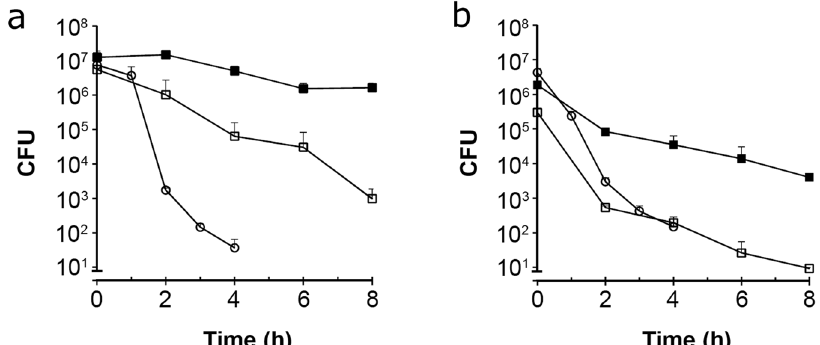
Fig. 6 Antibiotic time-kill assay of P. aeruginosa bio fi lms and dispersed cells. Bio fi lms were grown on pegs for 24 h, and were subsequently treated with 100 μ M H6-335-P1 or DMSO-control for 2 h. Bio fi lms treated with H6-335-P1 ( □ ) and DMSO-control ( ■ ), as well as dispersed cells ( 〇 ) were then challenged with 30 µg/ml tobramycin ( a ) or 0.5 µg/ml cipro fl oxacin ( b ). The bio fi lms were disrupted at 0, 2, 4, 6, and 8 h, and planktonic cells were withdrawn at 0, 1, 2, 3, and 4 h, and the bacteria were plated on agar plates for CFU determination. Mean values and standard deviation (bars) of three biological replicates ( n = 3) are shown.